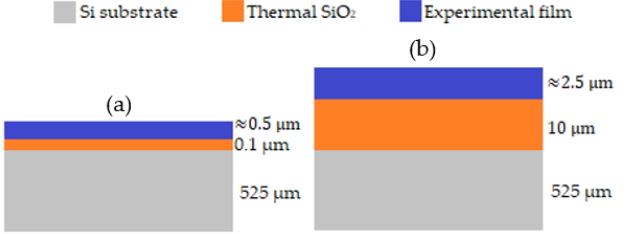
Figure 1. ( a ) Model of the structure used in the SiON film analysis; ( b ) model of the structure with 2500 nm thick SiON film.